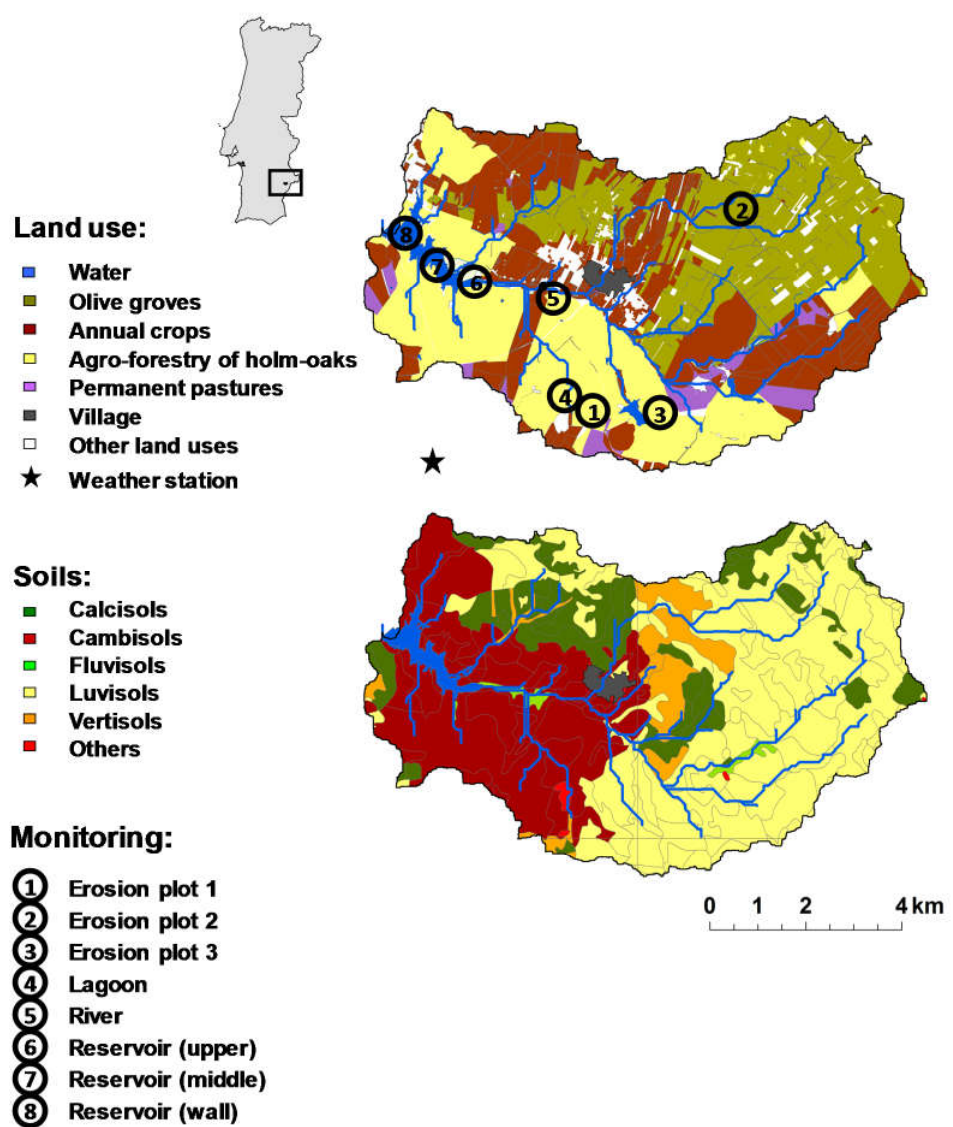
Figure 1. Location, land use (top) and major soil units (bottom) in Enxoé.